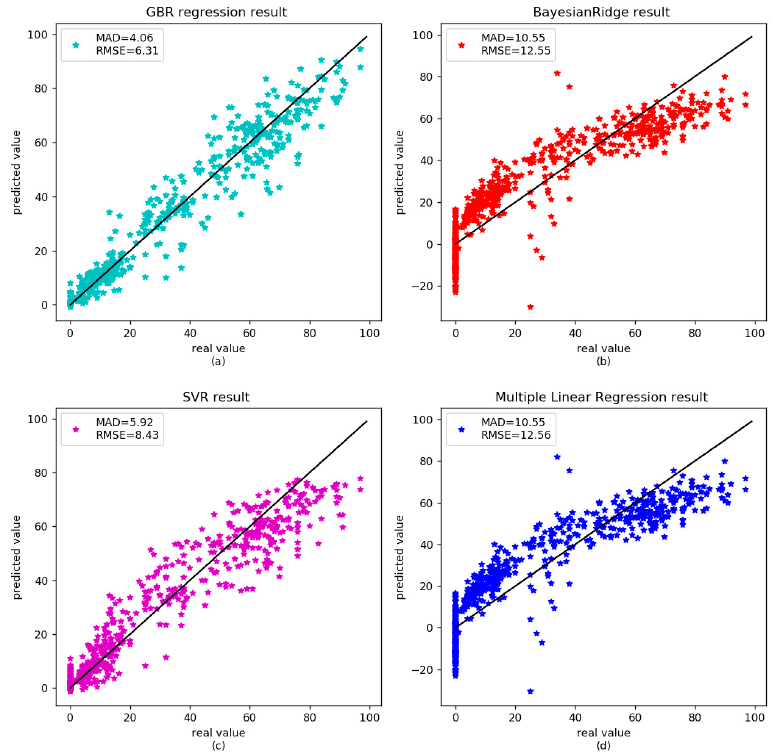
Figure 2. Comparison between the real age and the age predicted by the four models in the validation dataset of healthy data.